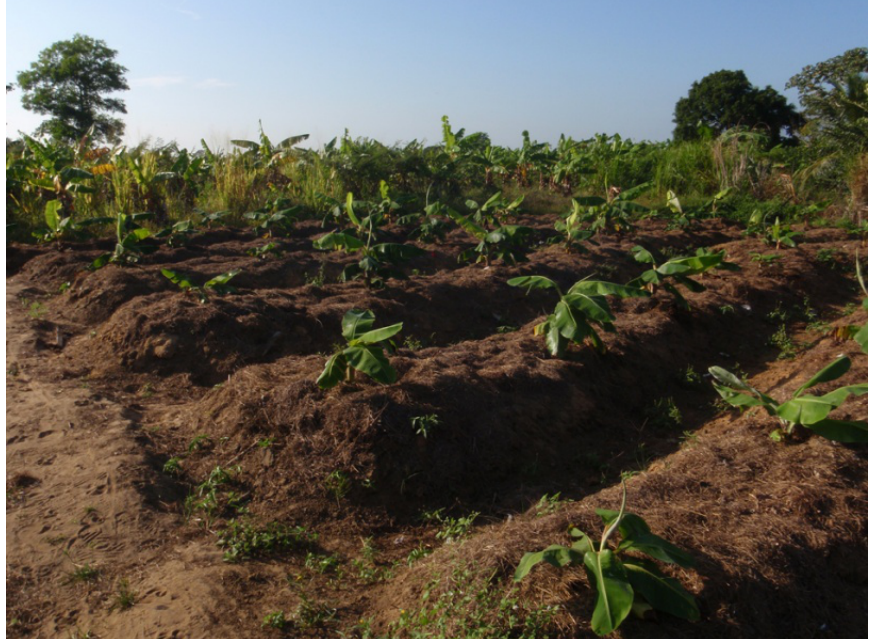
Figure 14. Modern small raised fields made on dry area by Haitians near